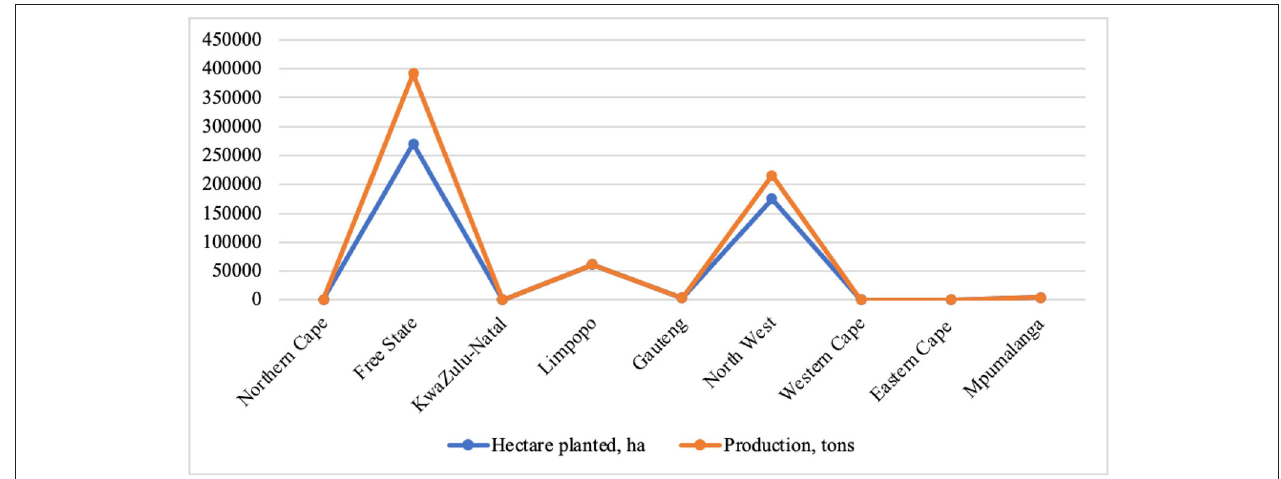
FIGURE 1 | Stylized provincial contributions to sunflower production in South Africa (2018/2019 season).